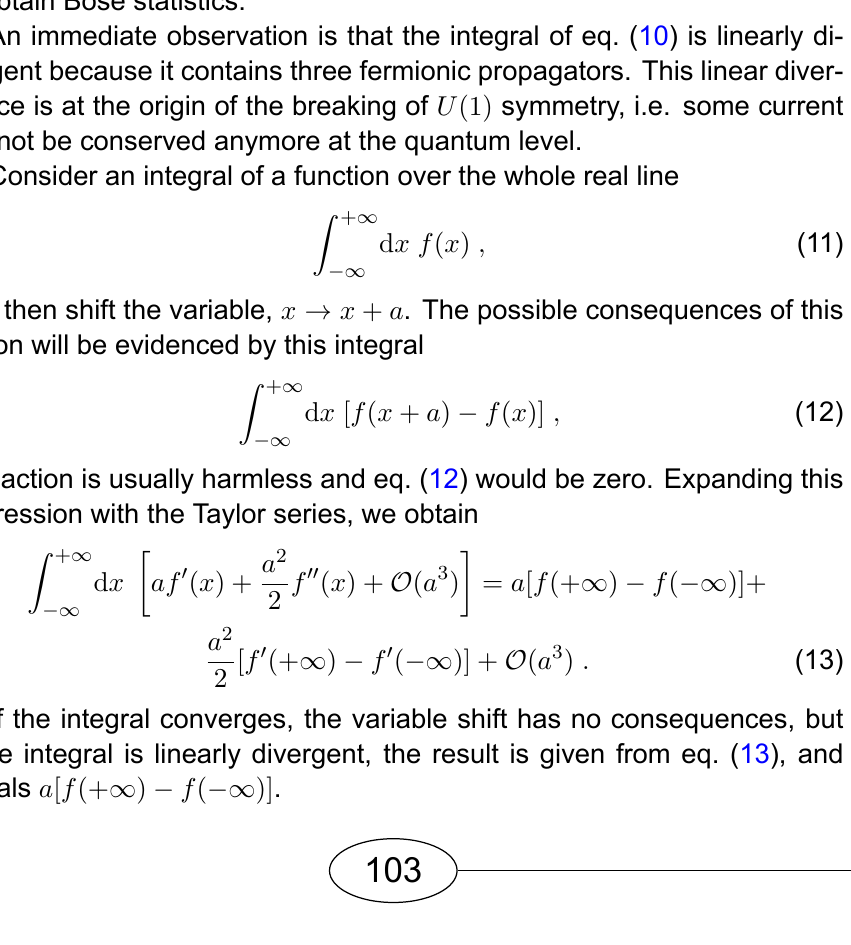
Figure 1 – Triangle diagram, 1 Рис. 1 − Треугольная диаграмма, 1 Слика 1 – Дијаграм троугла, 1